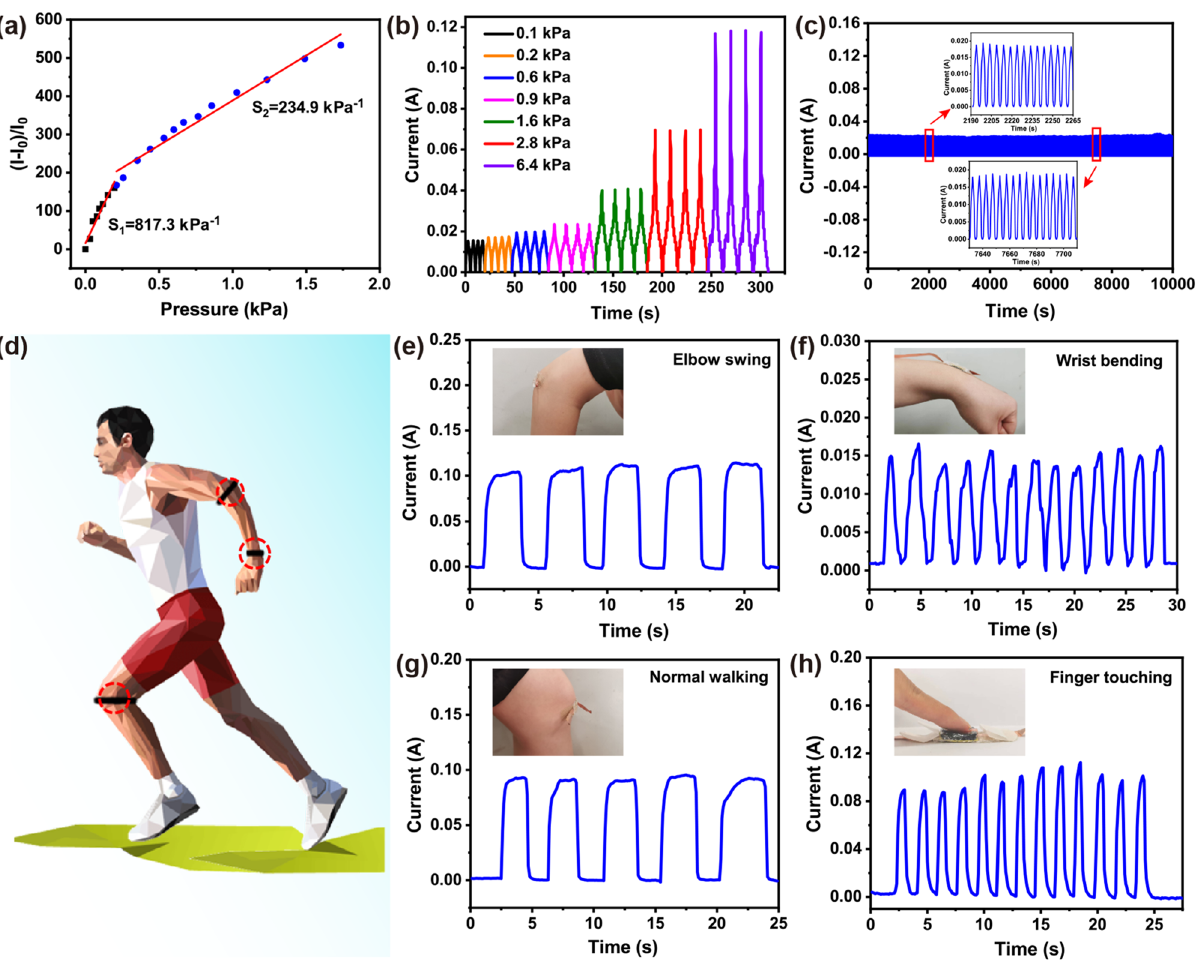
Fig. 4 a The relationship between the change of the relative current and the linear sensitivity of the pressure sensor. b Current response at vari- ous pressures of 0.1–6.4 kPa. c Current stability at 20% strain for 2000 cycles. d Illustration diagram of application in human behavior